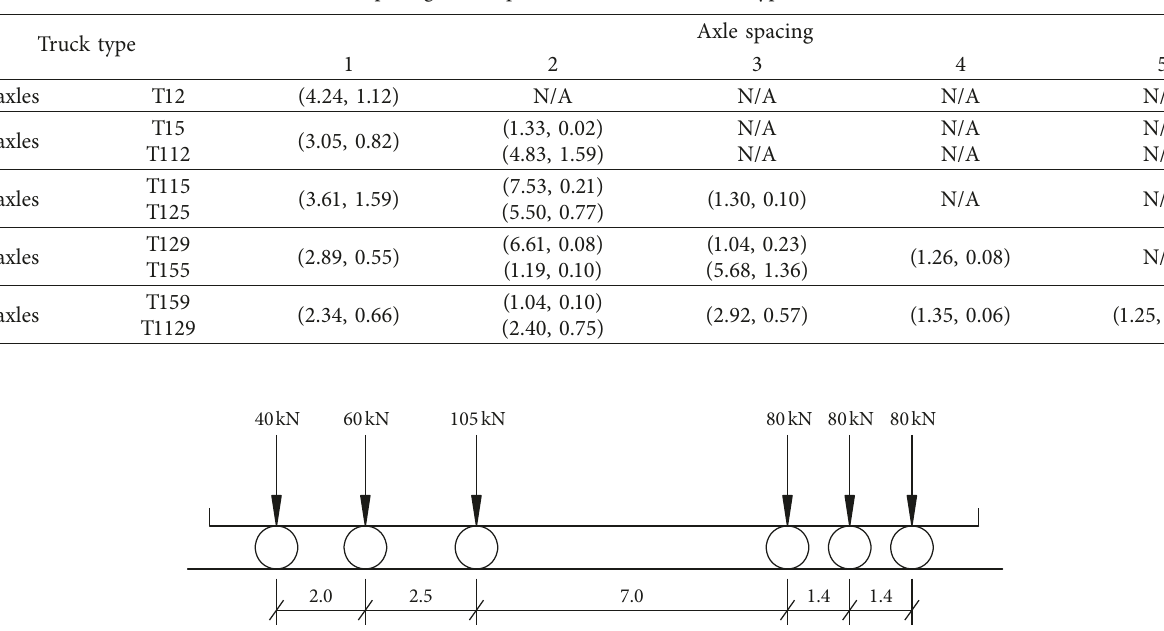
Table 6: Estimated axle spacing model parameters for each truck type (mean, standard deviation).